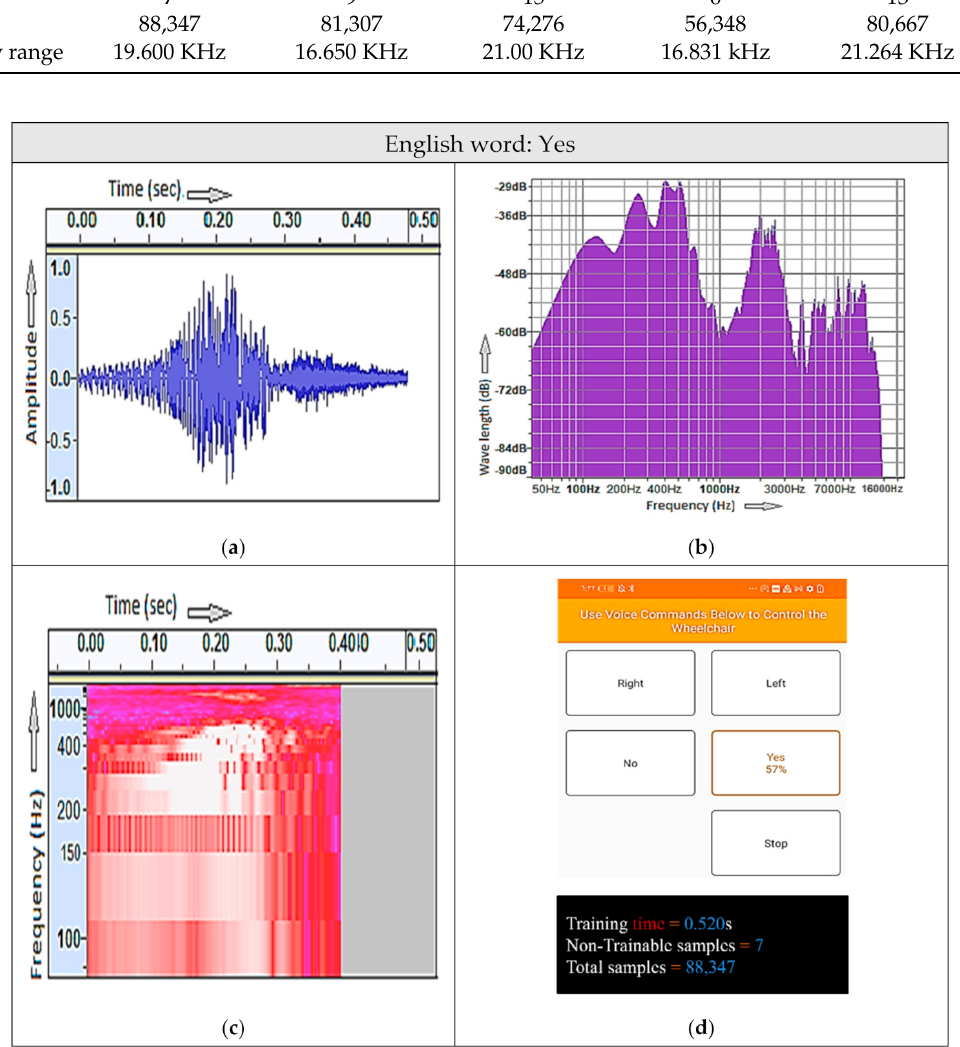
Figure 5. Recognition of the “Yes” voice command. ( a ) Audio shape; training time = 0.520 s; ( b ) long- term spectrum; frequency range = 19.6 kHz; ( c ) spectrogram; ( d ) screenshot on the mobile